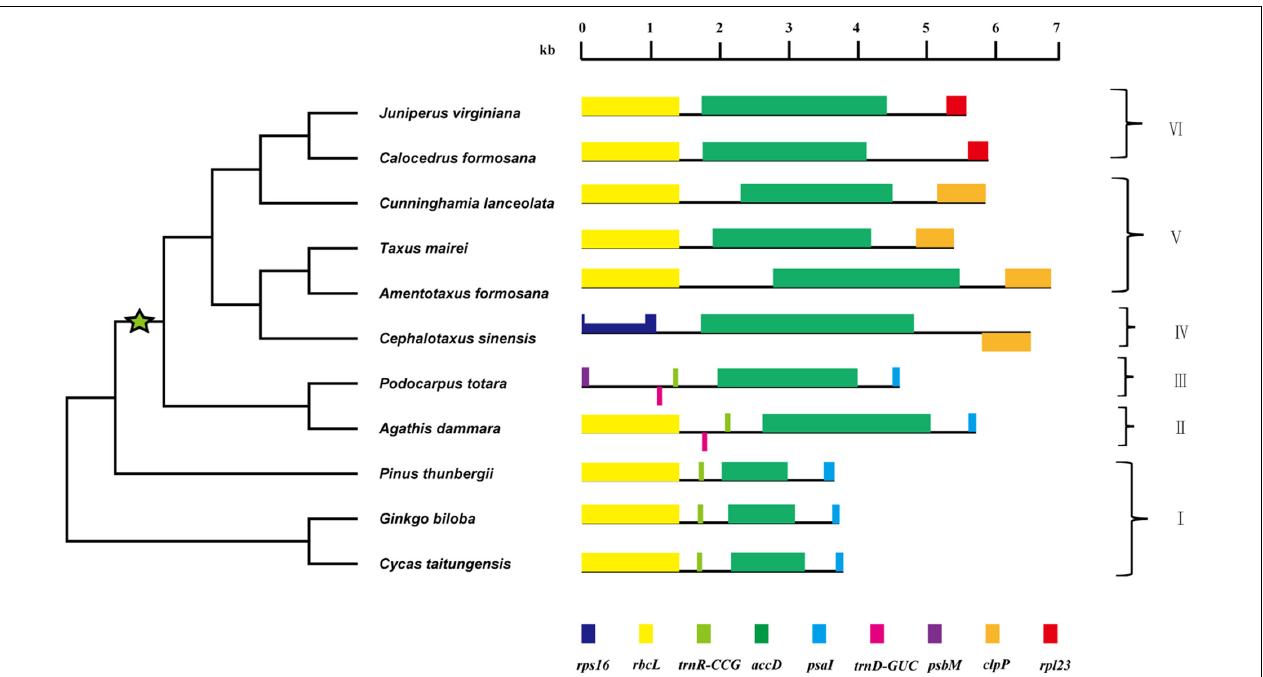
FIGURE 3 | Gene organization around the accD locus in gymnosperms. Green star indicates the lineage where accD has expanded. Genes shown above line are transcribed from left to right, while those located below line are transcribed opposite direction. The half-height region in rps16 represents an intron. The topology (not drawn to scale) in the left side was the same as accD d N tree in Figure 2 . The roman numbers I–VI denotes six types of gene organization around the